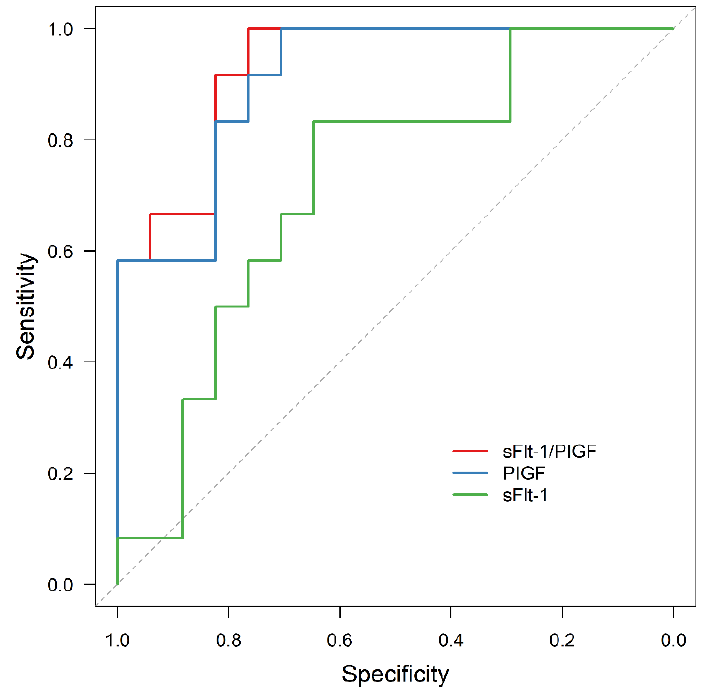
Figure 6. ROC curve for APO prediction in the subgroup of overweight women by sFlt-1 (AUC = 0.721, 95% CI: 0.531–0.910, p = 0.046), PIGF (AUC = 0.912, 95% CI: 0.811–1.000, p < 0.001) and sFlt-1/PIGF (AUC = 0.931, 95% CI: 0.845–0.999, p < 0.001). ROC receiver operating characteristic, APO adverse perinatal outcome, sFlt-1 soluble fms-like tyrosine kinase-1, PIGF placental growth factor.